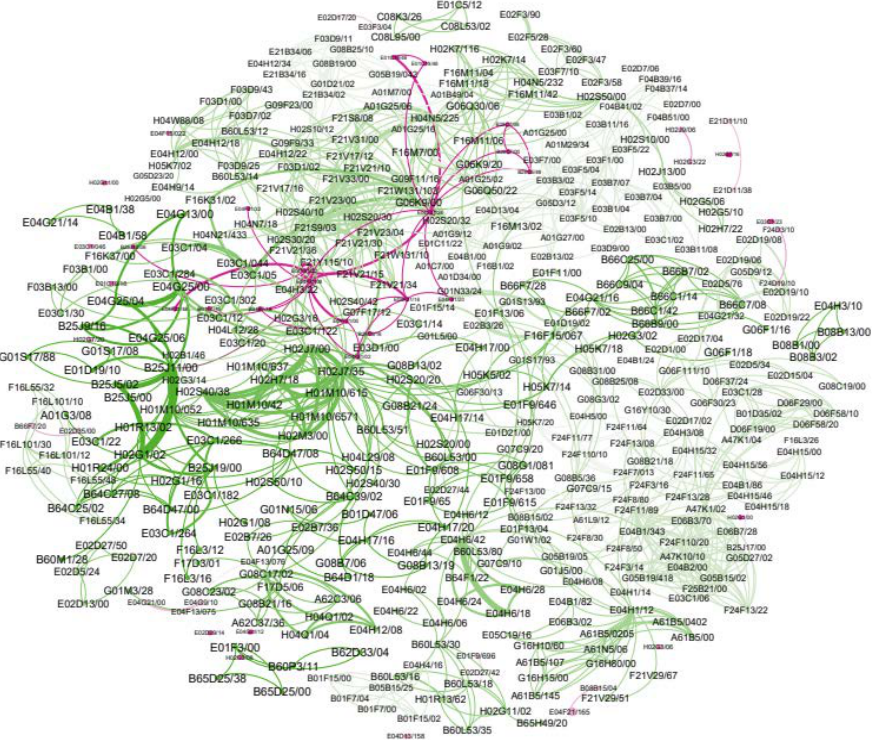
Figure 10. Digital construction innovation network (2020).